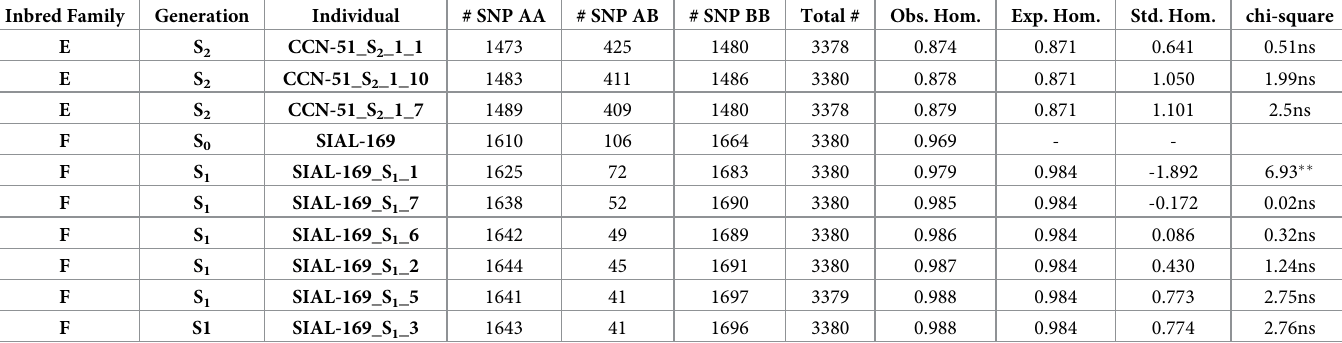
the original SIAL-169 parent. As expected, for the other five families, the range and the average